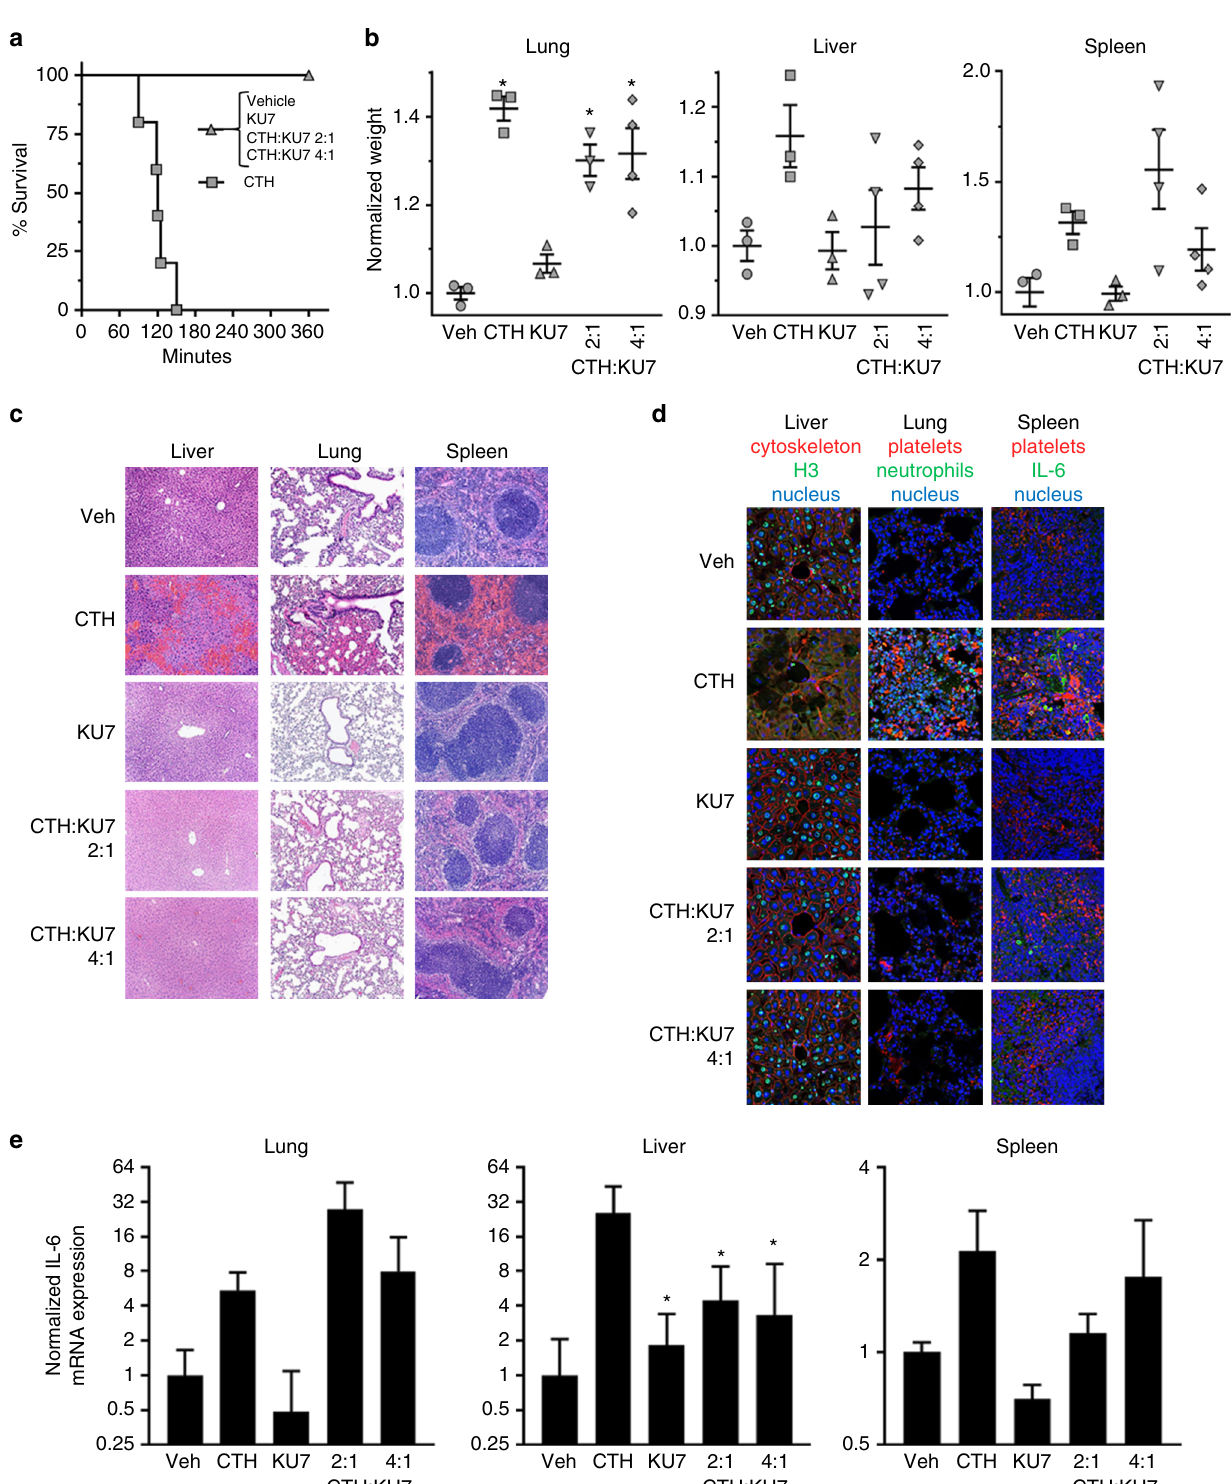
Fig. 4 Ef fi cacy of histone aptamer in murine model of MODS. a Survival curves of mice injected IV with CTH in the presence or absence of aptamer treatment; n = 6 per group. Molar ratio of CTH to aptamer indicated. b Weights of the liver, lung and spleen normalized to pre-treatment body weight; * p < 0.05 vs. Veh, one-way ANOVA corrected for multiple comparisons (Dunnett testing), n = 4 – 6 per group, data represent mean ±SEM. c Histology of the liver, lung and spleen of vehicle, CTH, KU7, CTH + KU7 (2:1), and CTH + KU7 (4:1) treated mice. Vascular congestion, thrombi and hemorrhaging are observed in the CTH mice. Scale bar = 100 µ m. d Immunostaining of mouse liver, lung and spleen stained to identify nucleus (pseudo blue), cytoskeleton and platelets (pseudo red), histone H3, neutrophils and IL-6 (pseudo green) (see Supplementary Fig. 4 for quantitative analysis of immunostaining data). Scale bar = 25 µ m. e Normalized IL-6 mRNA expression levels in the liver, lung and spleen of mice. Normalized IL-6 mRNA expression was determined using the following equation: 2^( Δ - Δ CT). Δ CT = beta actin − IL-6, Δ - Δ CT = Vehicle Δ CT − Treatment Δ CT. Error bars represent the lower limit (LL) and upper limit (UL) of the standard deviation from the Δ - Δ CT [2^(LL Δ - Δ CT) and 2^(UL Δ - Δ CT)]; * p <0.05 vs. CTH (50 mg kg − 1